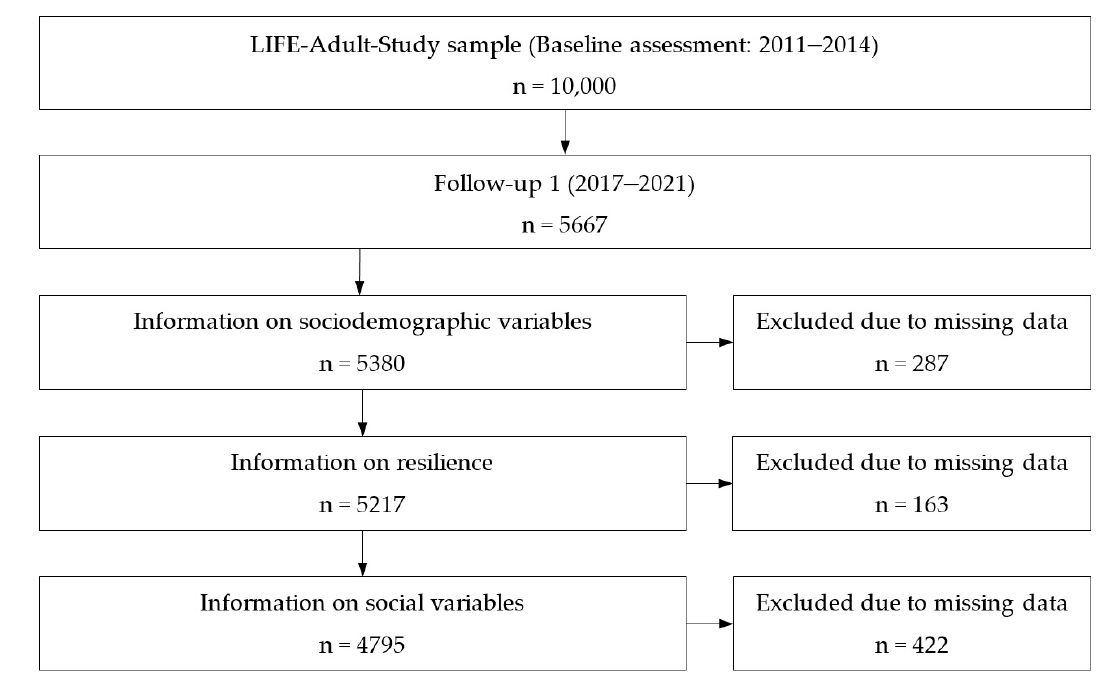
Figure 1. Formation of the sample.